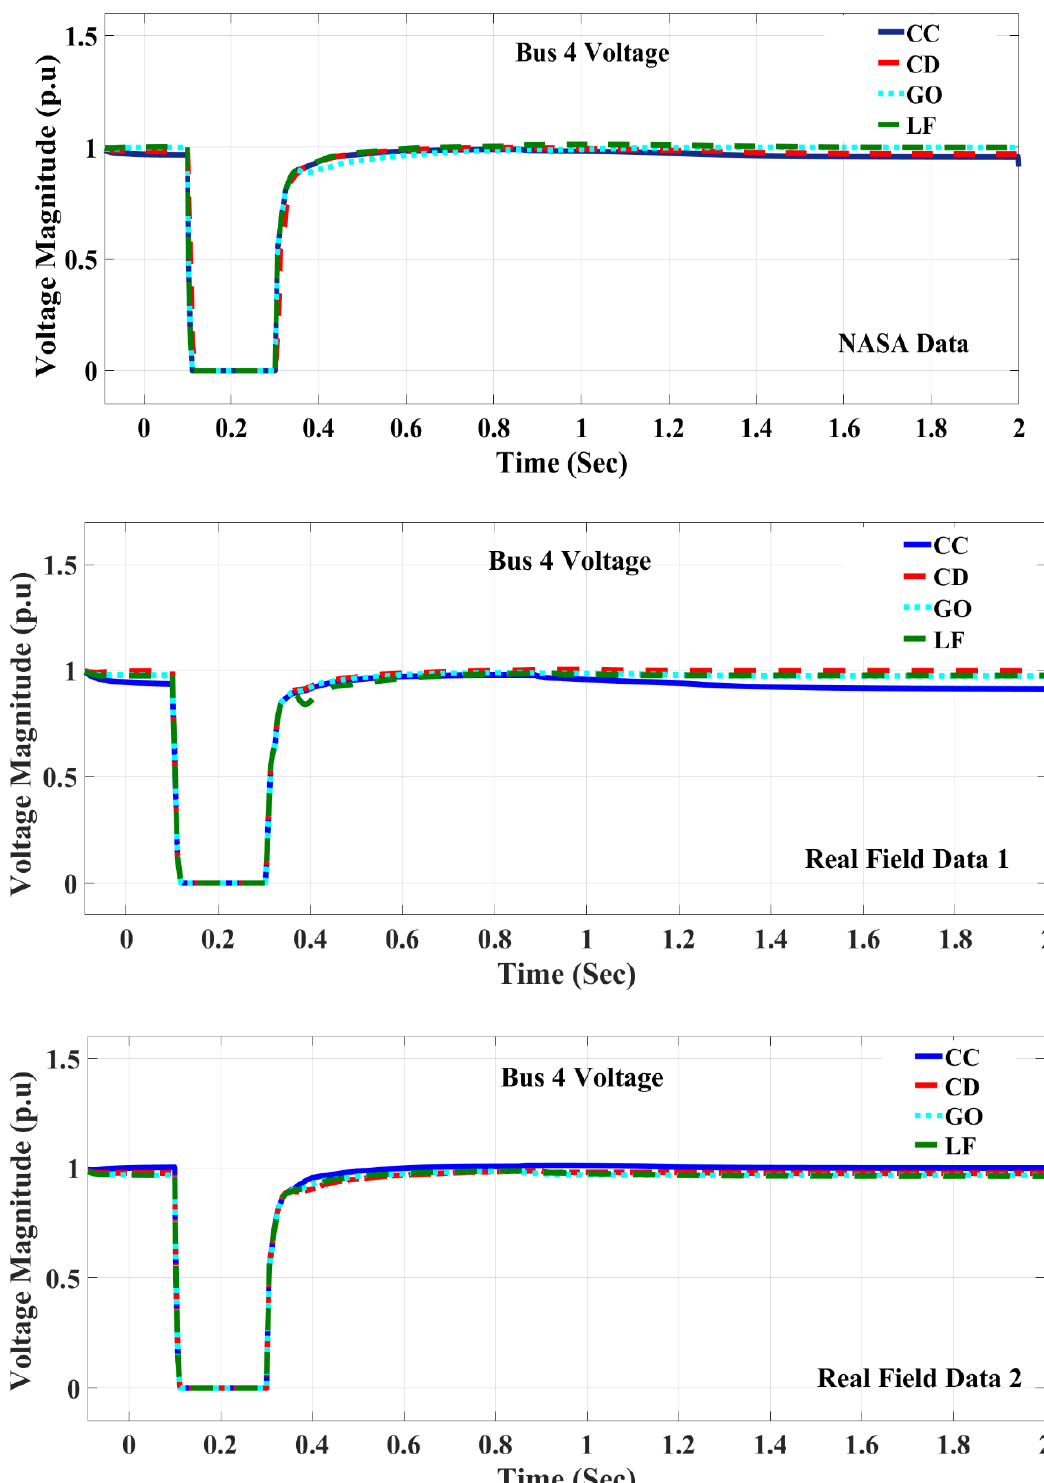
Figure 9. Voltage responses at Bus 4, according to the four dispatch strategies.